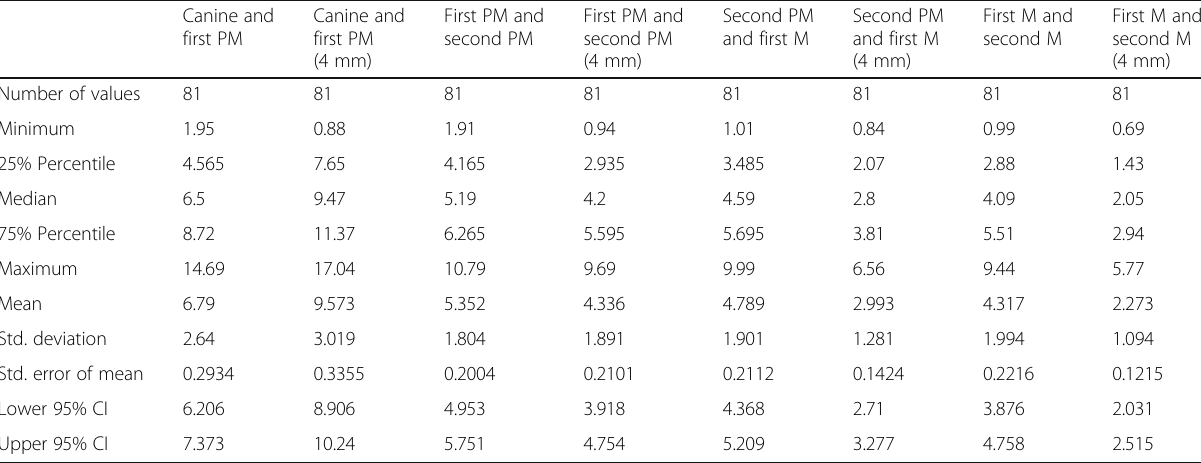
Table 4 Palatal bone thickness in non-growing female